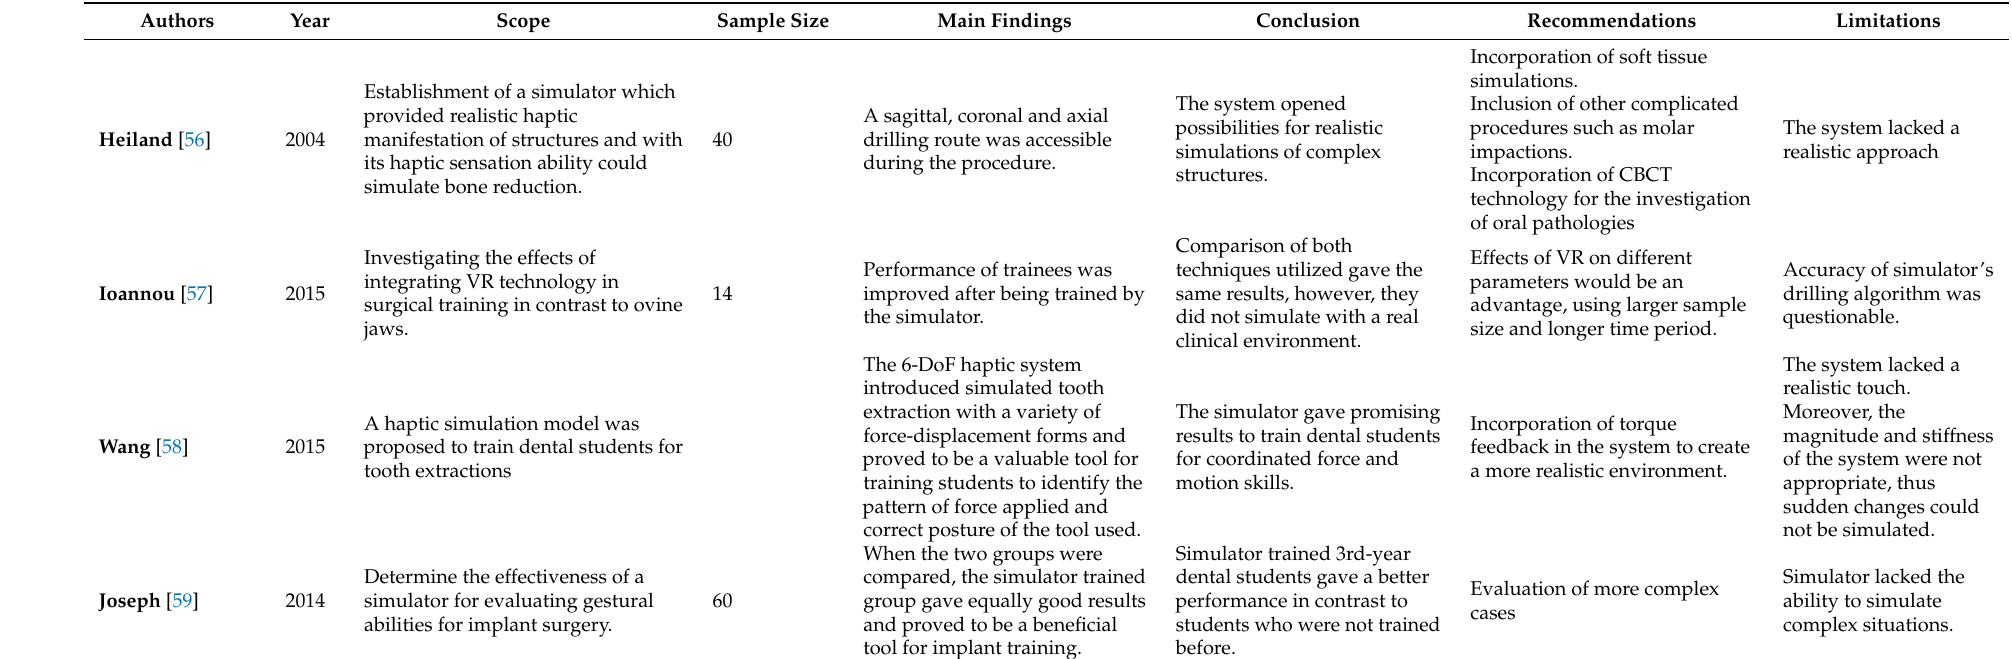
Table 4. Application of virtual reality simulation (VRS) in oral and maxillofacial